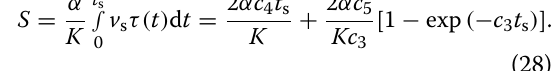
2 l , fault zone thickness; α , thermal diffusivity; t , time elapsed after event; t s , slip duration a From Ma et al. (2003, 2006), Hirono and Hamada (2010), Kano et al. (2006) b From Fulton et al. (2013) c From Li et al. (2013, 2015), Yagi et al. (2012)